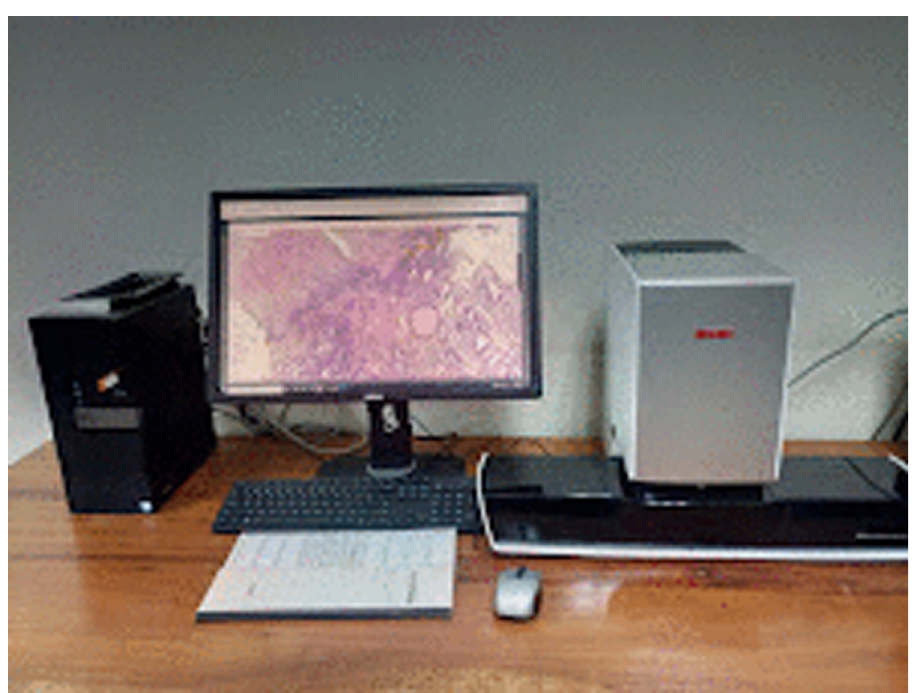
Fig 1. A photograph of the Motic telepathology platform.